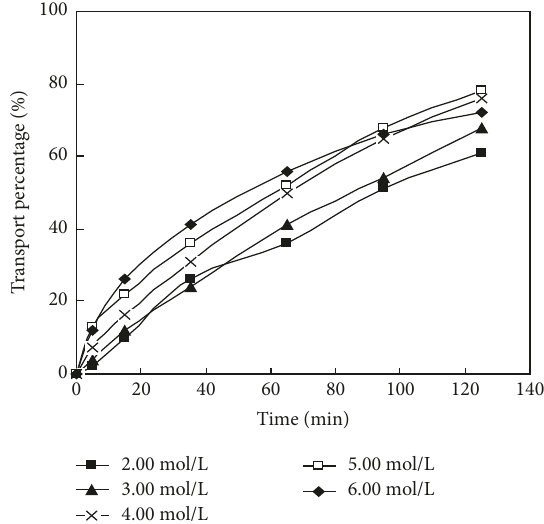
Figure 3: Effect of HCl concentration in dispersion phase on transport of La